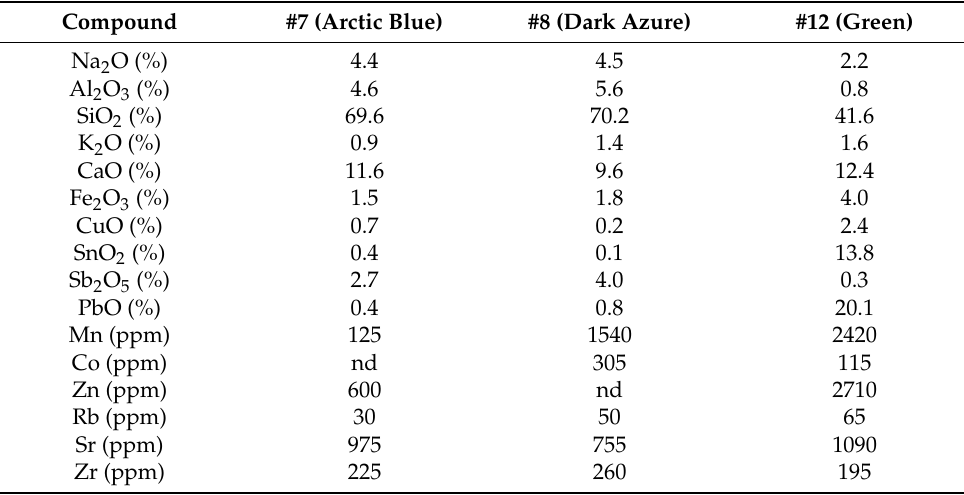
Figure 12. Representative bulk EDXRF patterns for the three sampled glass tesserae from the Circus mosaic showing relevant element peaks. In particular, Sb and Cu for tesserae #7 (arctic blue); Sb for tessera #8 (dark azure); and Pb, Sn, and Cu for tessera #12 (green). Inset, detail to reveal the presence of Co, in #12 and specially in #8. Table 3. Bulk composition of the three sampled glass tesserae as obtained by